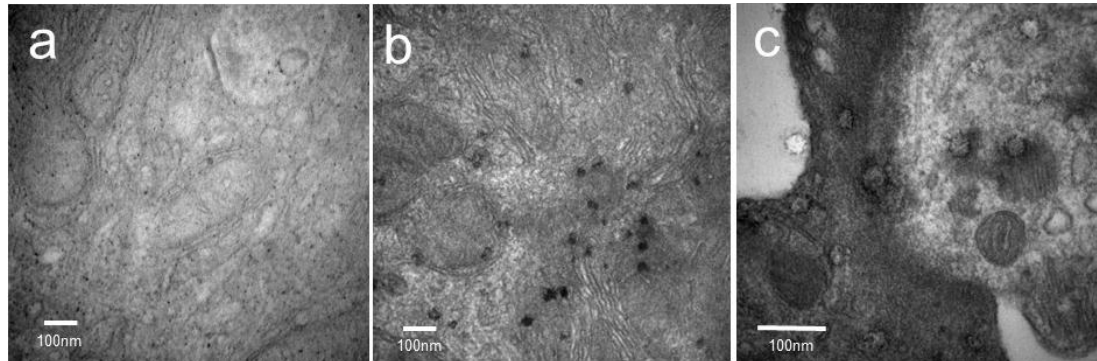
Figure 5. Nasal epithelia structure following the administration of NE and iron oxide-modified NE by TEM. ( a ) Nasal septa from mice treated with NE alone; ( b ) nasal septa from mice treated with iron oxide modified NE; ( c ) nasal septa from mice treated with iron oxide modified NE at the higher resolution.